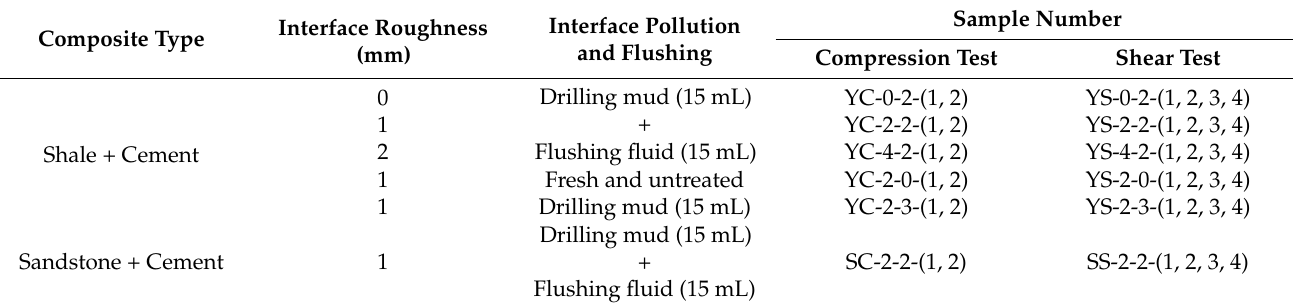
Table 3. Experimental